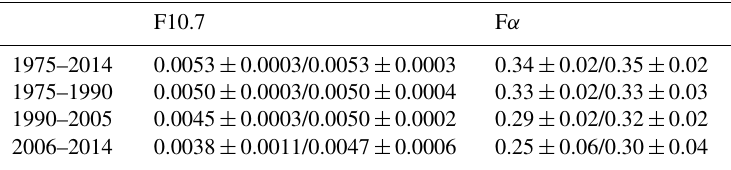
Table 2. Solar coefficient B from Eq. (1) for yearly values of fo E for the whole period and for three sub-periods, for Juliusruh and Chilton (values separated with a slash).